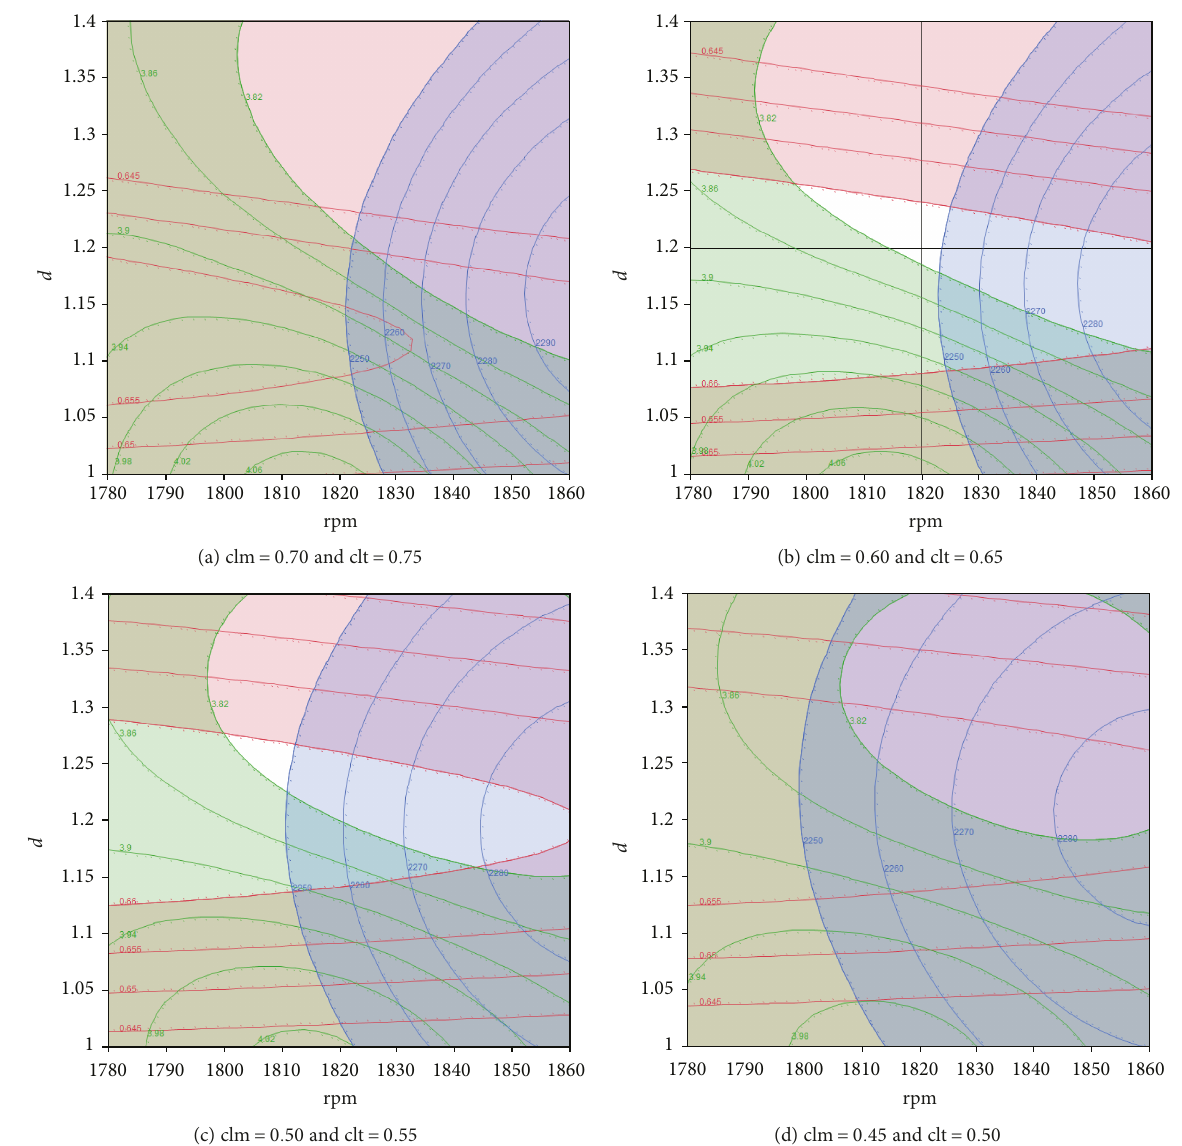
Figure 7: Contours of response surface from kriging metamodel (rpm- d